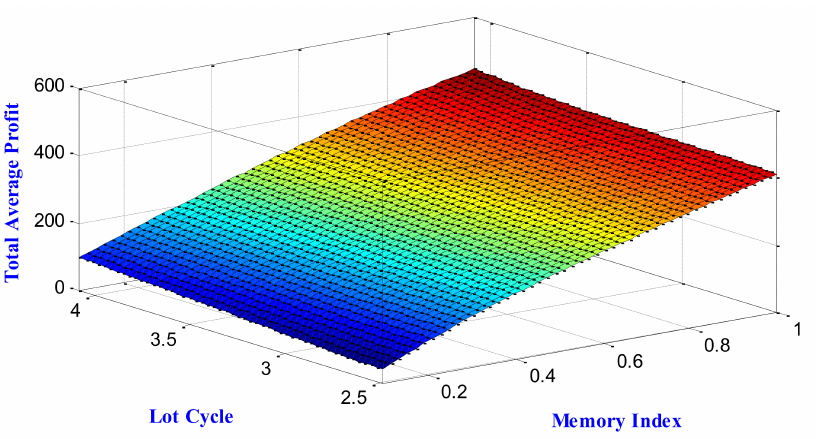
Figure 8. Three-dimensional dependency among total average profit, lot cycle and memory index for the case of no shortage.